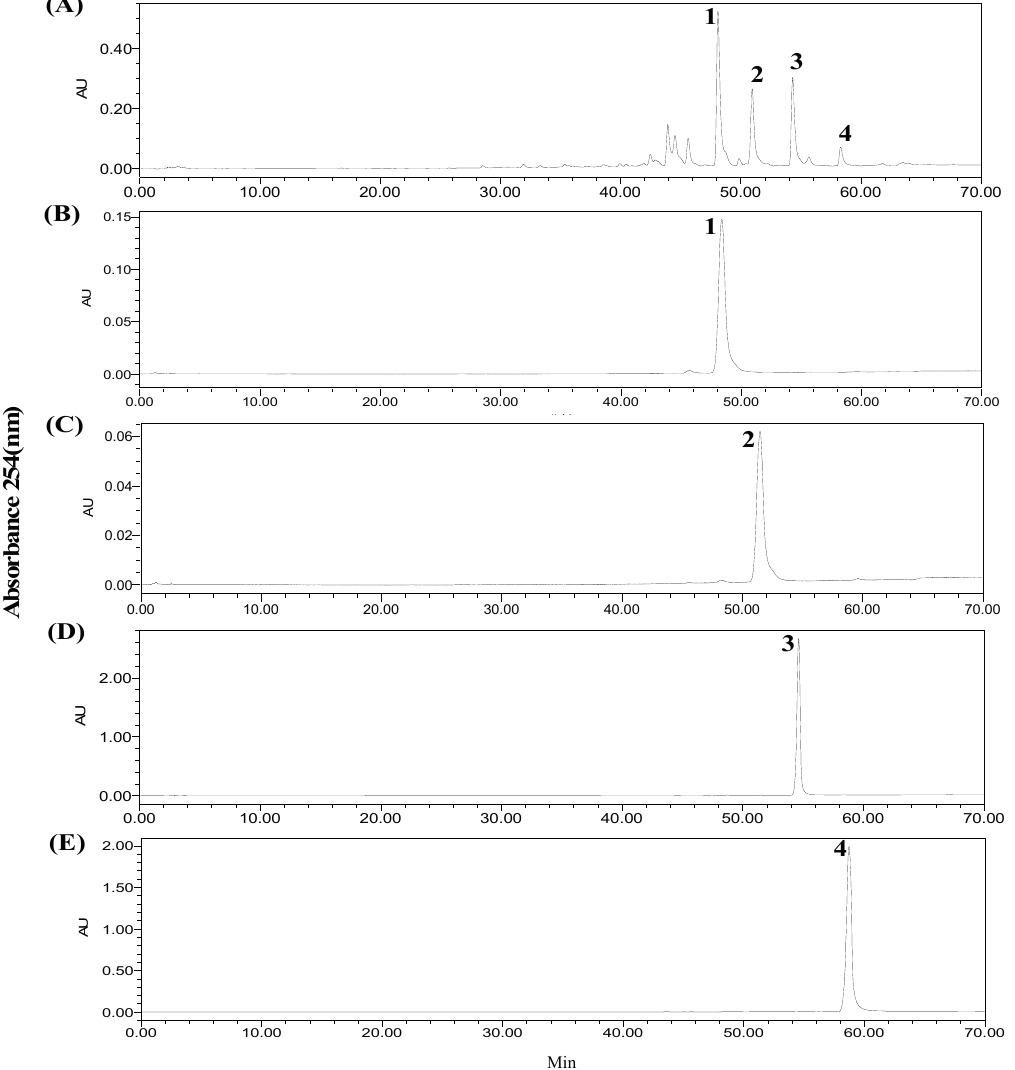
Figure 2. HPLC chromatograms. ( A ) Crude sample from J. procumbens ; ( B ) HSCCC fraction of peak 1 in Figure 3; ( C ) HSCCC fraction of peak 2 in Figure 3; ( D ) HSCCC fraction of peak 3 in Figure 3; ( E ) HSCCC fraction of peak 4 in Figure 3. Conditions: YMC-Pack ODS-A column (150 mm × 4.6 mm I.D., 5 µm); column temperature, 25 °C; mobile phase, methanol and water at the gradient (methanol: 0–60 min, 10%–90%; 60–70 min, 90%); flow rate, 0.8 mL/min; detection, 254 nm.